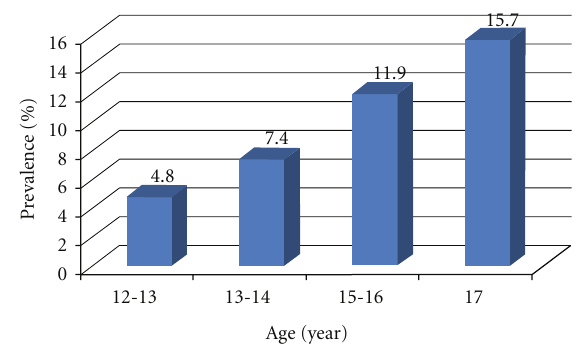
Figure 1: Prevalence of elevated blood pressure in Egyptian adolescents according to age.